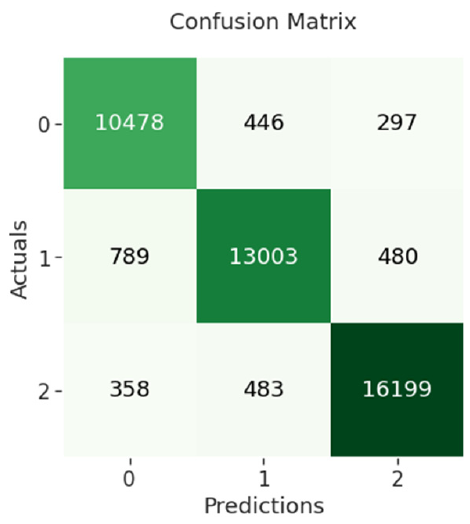
Figure 9. BERT-RNN confusion matrix.